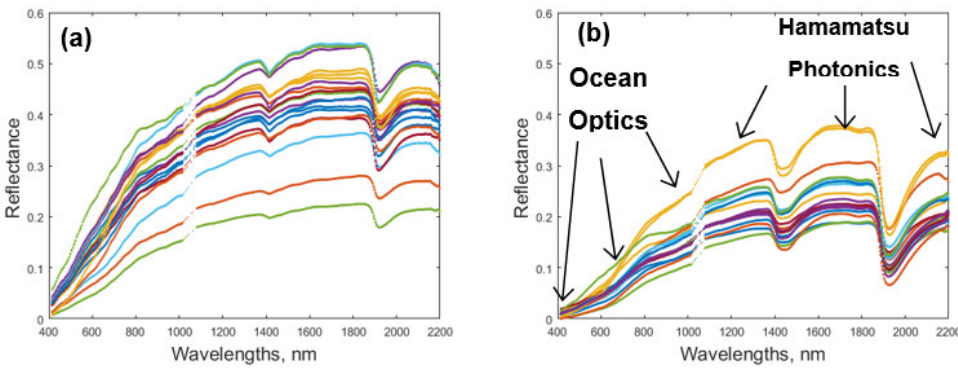
Figure 6. Examples of vis–NIR soil spectra (ex situ ( a ) and in situ ( b )).